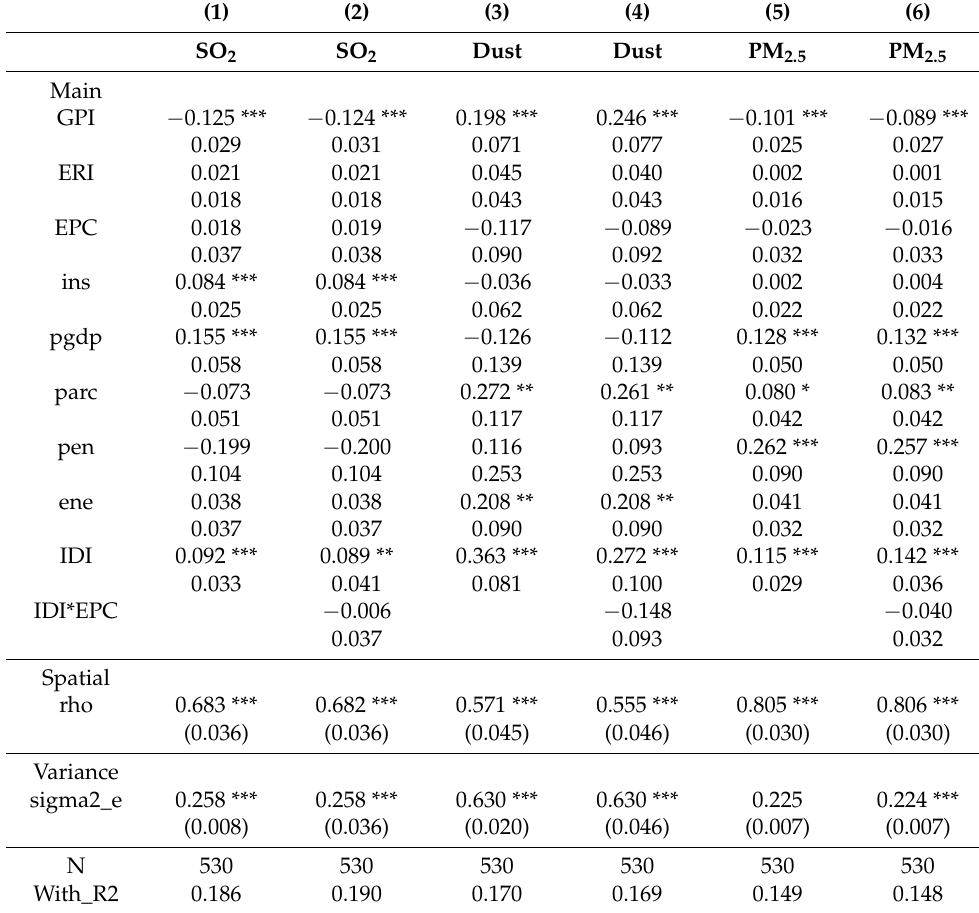
Table 4. Results of the spatial autoregressive model